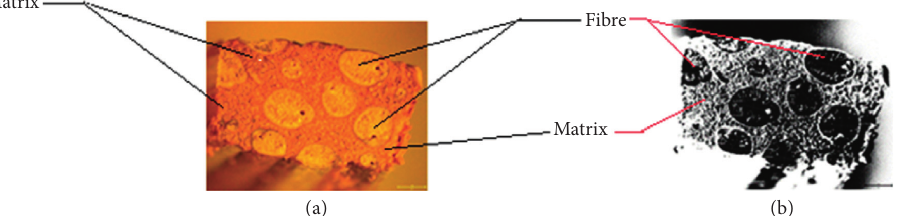
Figure 2: Cross section of a sample (PL-1/4-R3) of RVP. (a) Optical microscope (16x). (b) ImageJ.